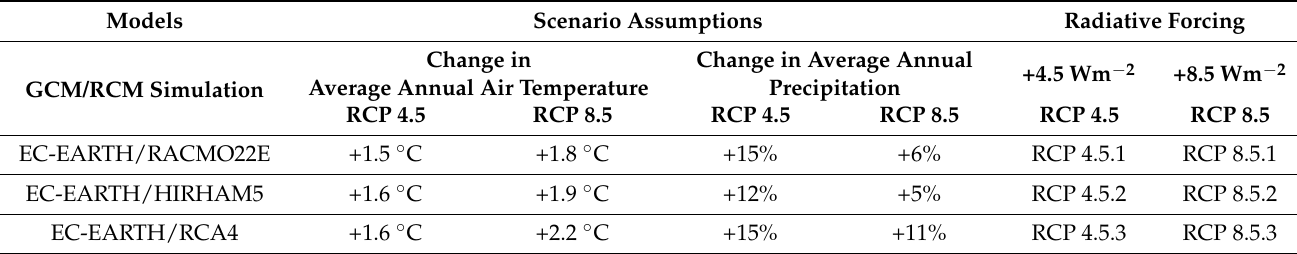
Table 2. Description of GCM/RCM simulations divided depending on radiative forcing. A